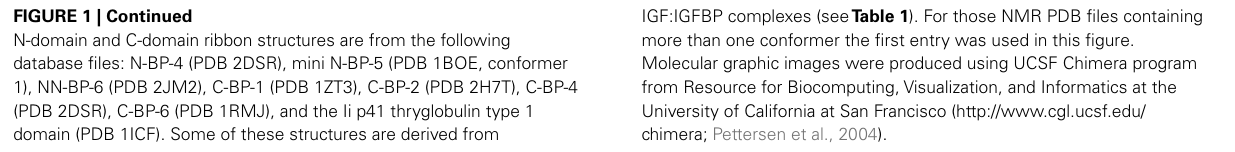
FIGURE 1 | Continued N-domain and C-domain ribbon structures are from the following